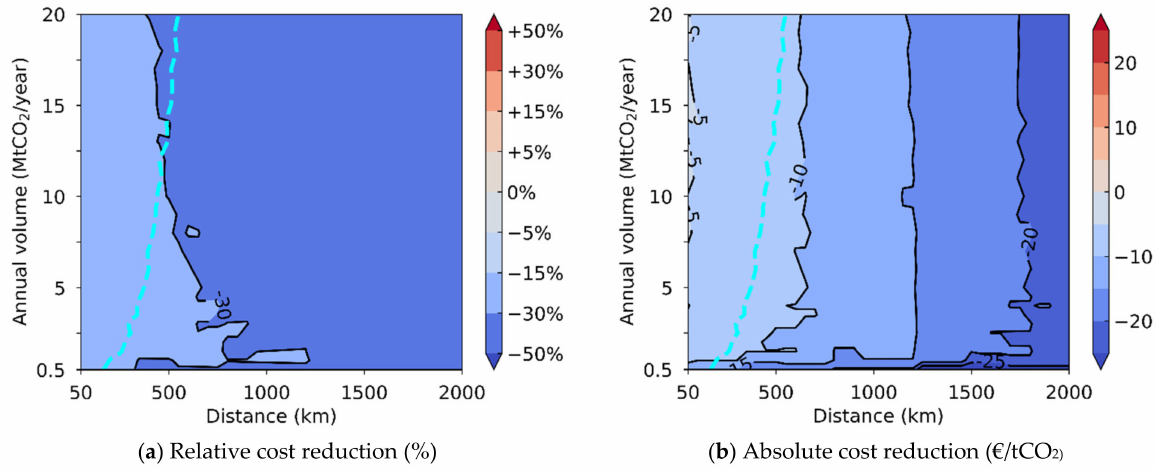
Figure 5. Cost comparison maps showing the cost reductions enabled by the 7 barg shipping transport compared to 15 barg in the case of shipping CO 2 to an offshore